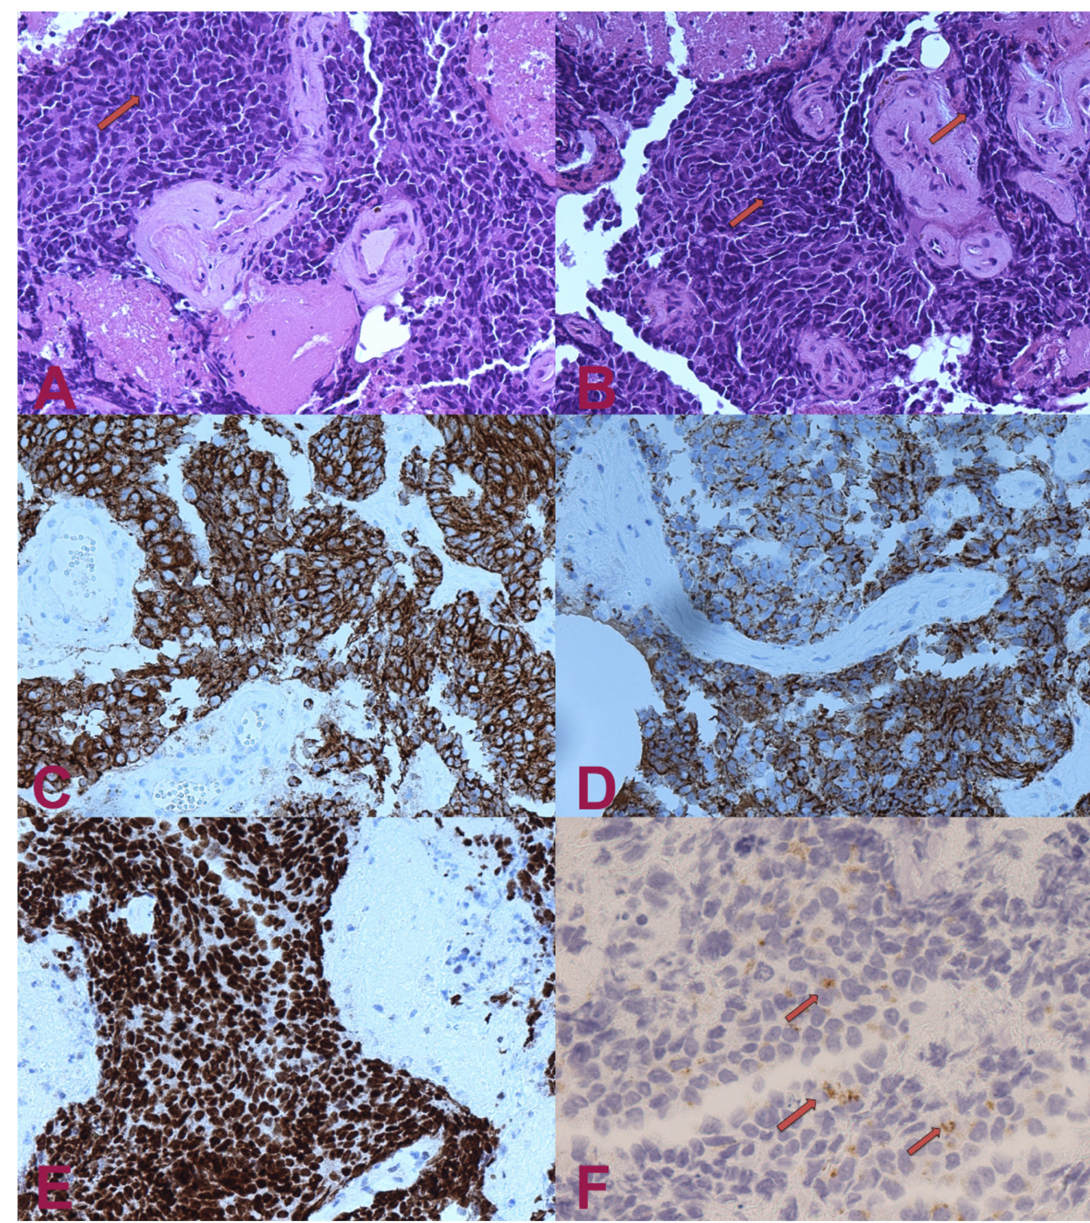
Figure 2. Histologic examination. ( A ) H.E.— small-cell carcinoma infiltrating nervous tissue. The cells have small, intense hyperchromatic nuclei, rounded and polygonal-shaped, and scant cytoplasm. Occasionally, it is possible to note “moulding” signs among the nuclei (arrow). ( B ) H.E.— in some areas, the nuclei have elongated shape (“fusiform”) or squashed (arrows). ( C ) Pan-cytokeratin (clone AE1/AE3)— the cytoplasm of the tumour cells are positive for cytokeratin. Staining for pan-cytokeratin, such as AE1/AE3, helps demonstrate that the tumour is a carcinoma rather than a lymphoid lesion (pan-CK negative and CD45 positive). ( D ) Positivity for cytokeratin 7 (CK7). Small-cell lung carcinoma (SCLC) is usually positive for CK7 and negative for CK20. About half of SCLC stain with CK7 and <10% with CK20. ( E ) Transcriptional Thyroid Factor 1 (TTF1)— strong positivity for TTF1 in almost all neoplastic cells is characteristic, but not specific, for small-cell carcinoma of the lung. Although the stain is less intense, it can be positive in 44–80% of extrapulmonary small-cell carcinomas. ( F ) Chromogranin A— dot-like granular positivity for chromogranin A is a marker of neuroendocrine differentiation of the neoplasm. Up to two-thirds of SCLC are negative for chromogranin and synaptophysin. When these markers are positive, this means that they have high specificity for neuroendocrine differentiation, unlike CD56, which is highly sensitive but not very specific. CD56 will stain approximately 90–100% of cases; however, it is less specific. The interpretation for SCLC diagnosis needs to be performed carefully in the appropriate morphological context and